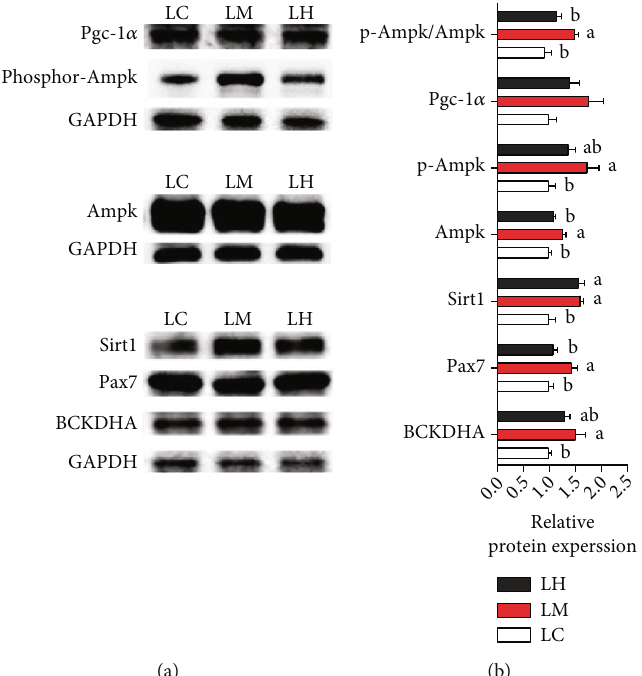
Figure 9: Western blot analysis of BCKDHA, Ampk, p-Ampk, Sirt1, Pgc-1 α , Pax7, and p-Ampk/Ampk in the muscle cells of blunt snout bream cultured in the three medium of leucine levels. Values are represented as mean ± SEM ( n = 4 ) by vertical bars. Mean values with di ff erent letters indicate signi fi